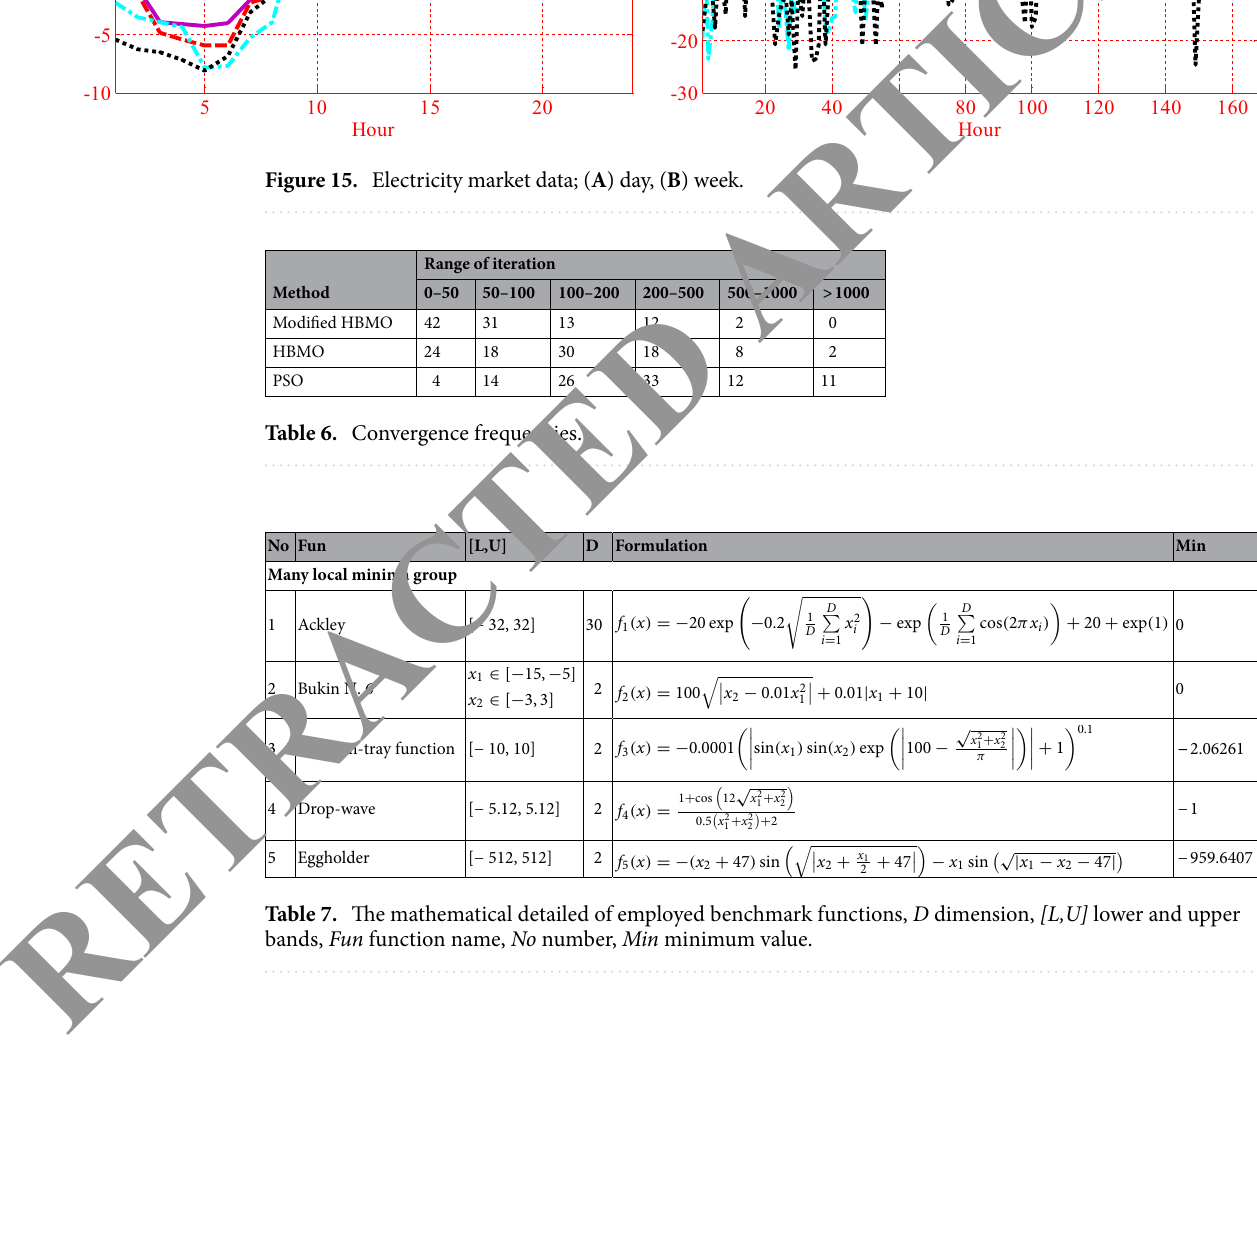
Figure 15. Electricity market data; ( A ) day, ( B ) week.